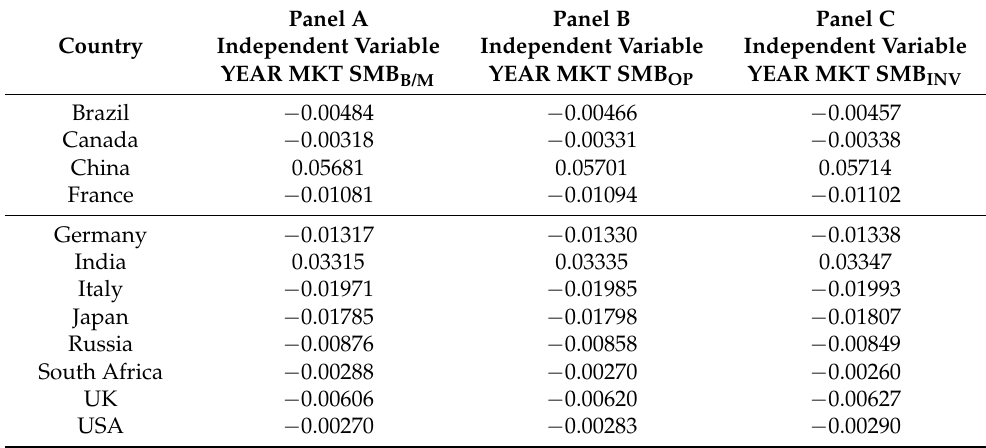
Table 13. Expected Values of Intercepts of Random Effects by Country Estimated by the Linear Trend Model with Explanatory Variables Regional Risk Factors Associated with the Final Complete Model. Panel C Panel B Panel A Independent Variable Independent Variable Country Independent Variable YEAR MKT SMB INV −